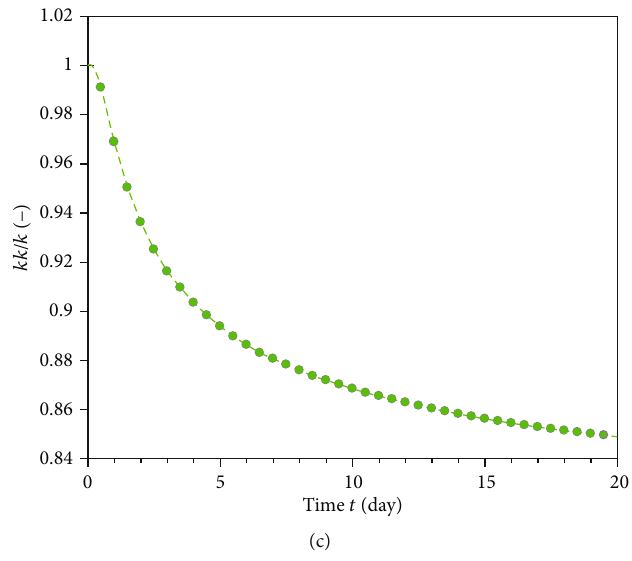
Figure 6: The evolution of temperature, oxygen concentration, and permeability ratio at monitoring point